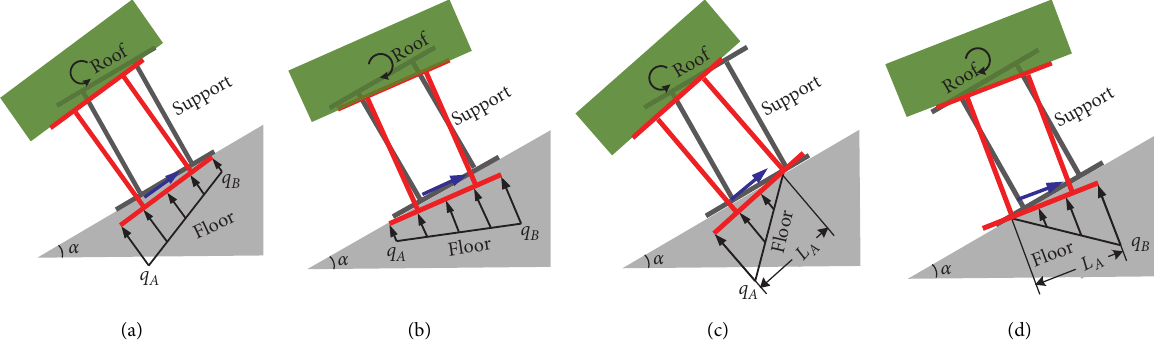
Figure 9: Interaction between the support and surrounding rock. (a) Subsidence+reverse rotation. (b) Subsidence+forward rotation. (c) Subsidence+reverse rotation +lift off. (d) Subsidence+forward rotation+lift